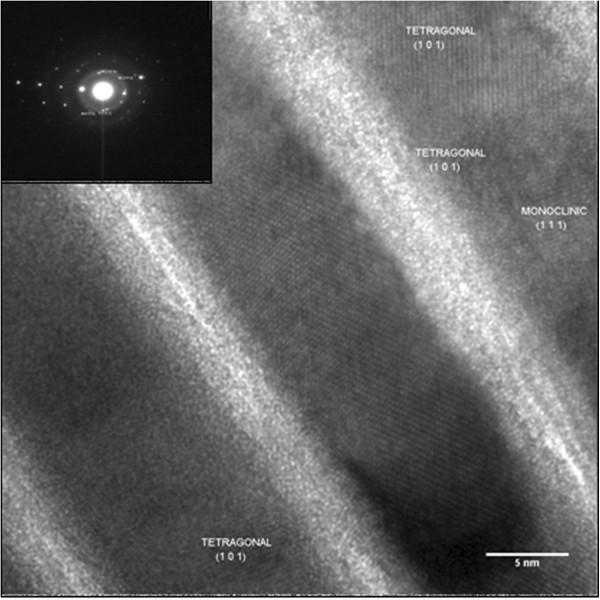
Bright-field image showing cross-sectional view of the as-deposited Al2O3/ZrO2multilayers (5:10 nm). Inset shows the SAED pattern from the multilayers.